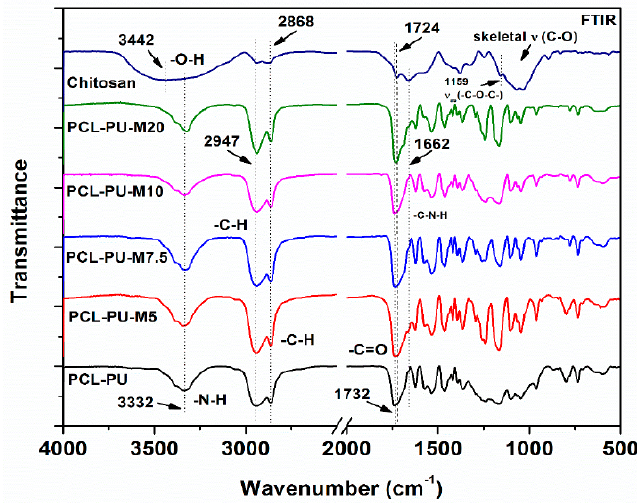
Figure 4. FTIR spectra of chitosan, 6. composites: polycaprolactone-polyurethane (PCL-PU) and PCL-PU-M (authors called PUR as PU and Chit as M) [34].